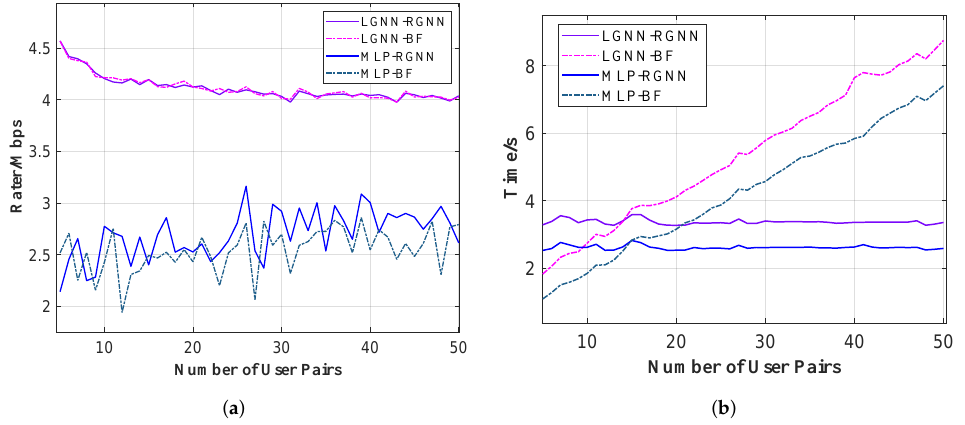
Figure 9. The relation of |V s | and on communication rate and computation time with constant |V u | = 4. ( a ) The relation of |V s | on communication rate. ( b ) The relation of |V s | on computation